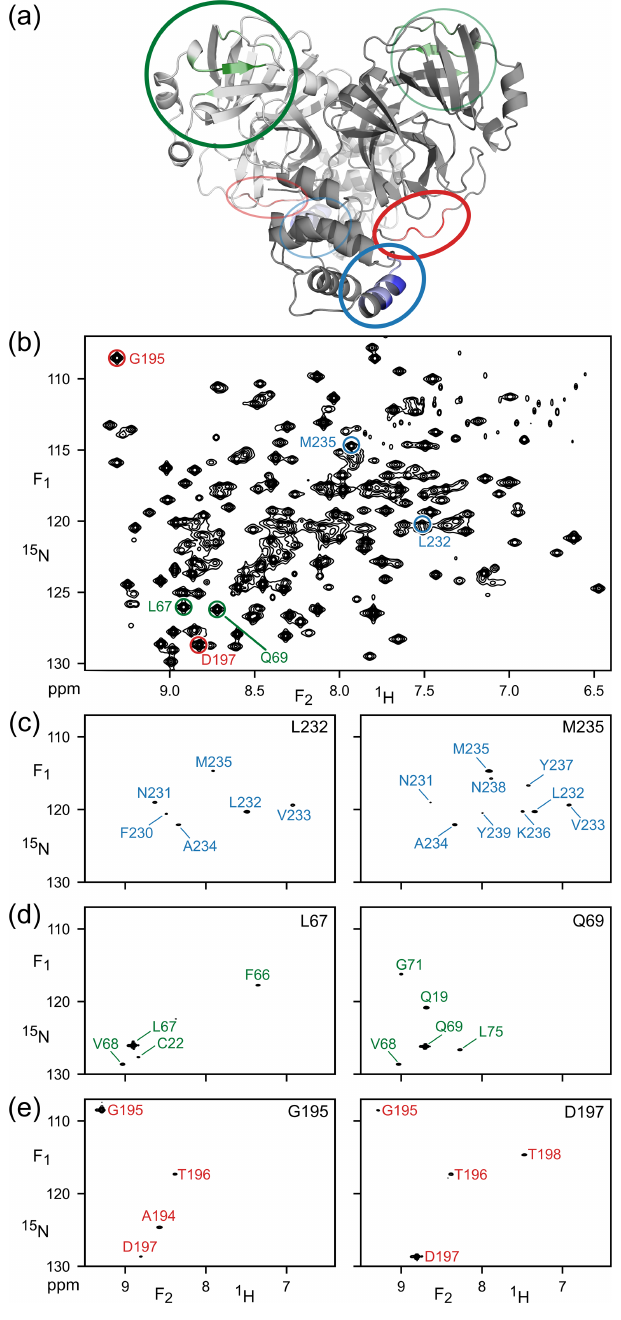
Figure 2. Illustration of amide–amide NOEs in perdeuterated, amide-protonated SARS-CoV-2 Main Protease, observed by 4D TROSY-NOESY-TROSY. (a) Ribbon diagram depicting the back- bone homodimeric X-ray structure (PDB: 6LU7), with colors mark- ing the regions that are highlighted in ( F 1 , F 2 ) cross sections taken at the ( F 3 , F 4 ) coordinates of (c) L232 and M235 (blue), (d) L67 and Q69 (green) and (e) G195 and D197 (red). These resonances are marked in (b) , which represents the most crowded region of the 800MHz 1 H– 15 N TROSY-HSQC (the full spectrum is shown in Fig.